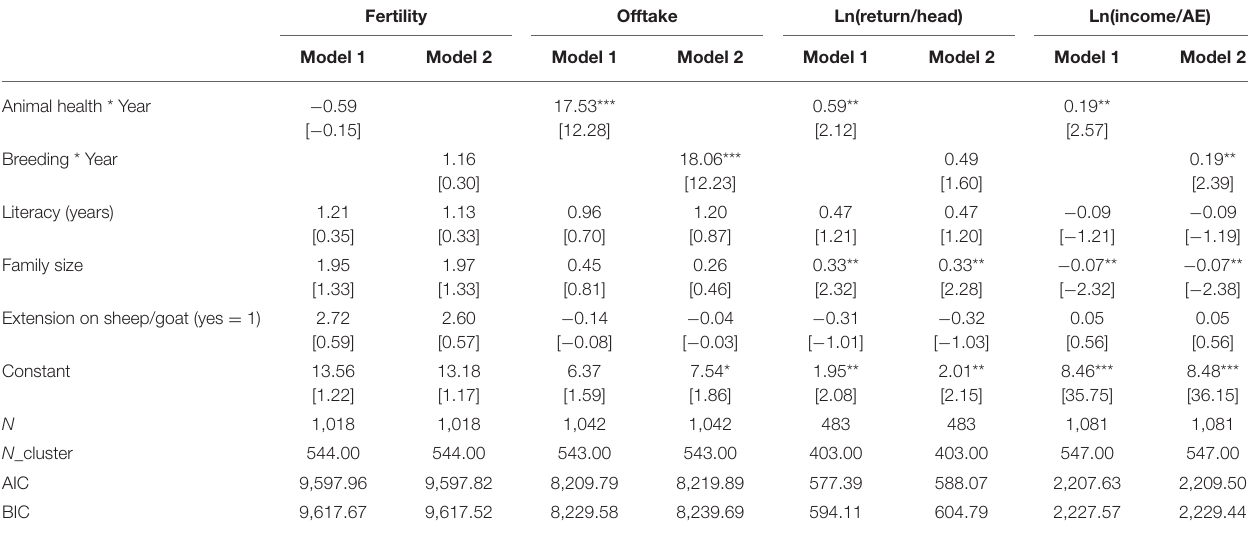
TABLE 7 | Treatment effect estimated using DiD with